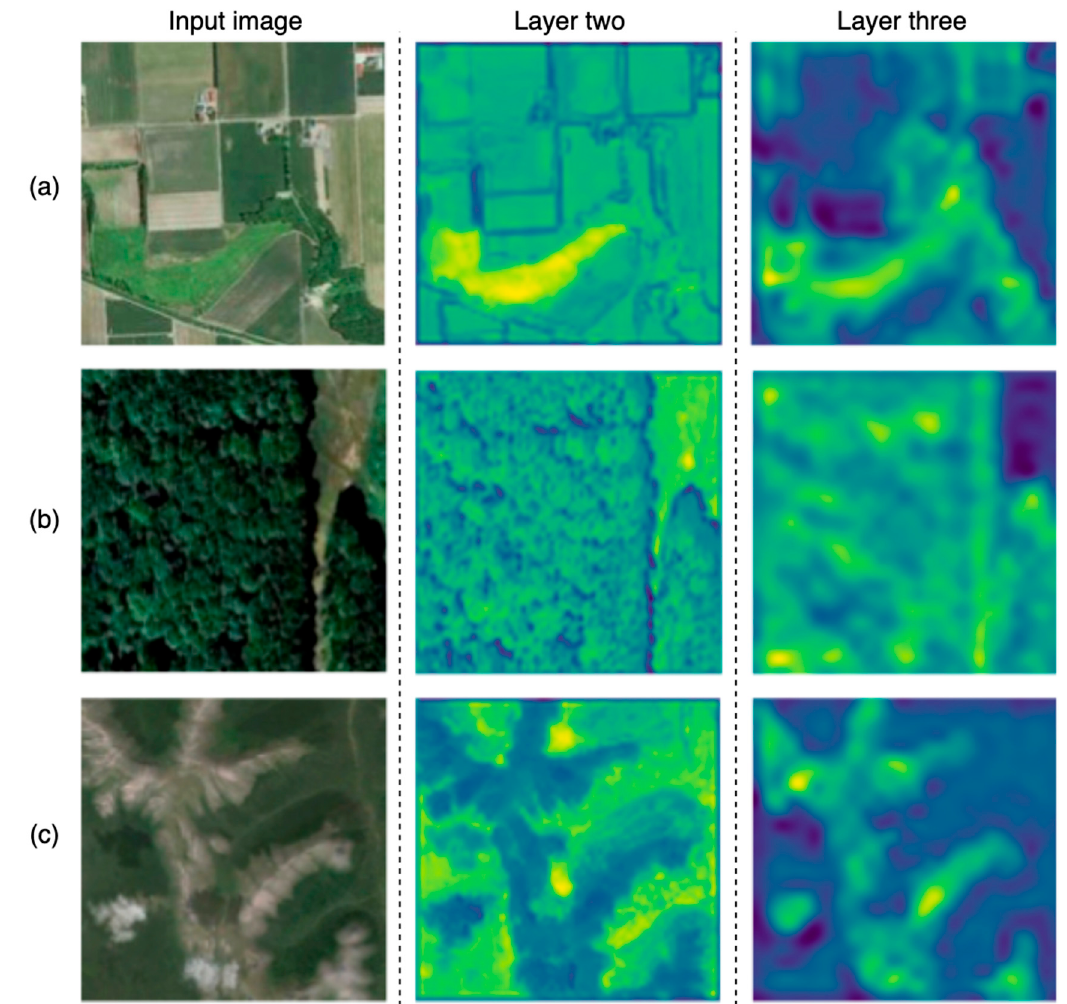
Figure 7. Original images and visualization of CNN feature maps reflecting their spatial resolution. Row ( a ) depicts Farm landscapes, row ( b ) shows Forest landscapes, and row ( c ) represents Mountain landscapes. Column one shows input images. Columns two and three are the corresponding feature maps extracted from our Tex-CNN layers two and three, respectively. Note that the CNN features are eigen maps with the highest eigen values obtained after applying PCA to feature tensors in layers two and three.